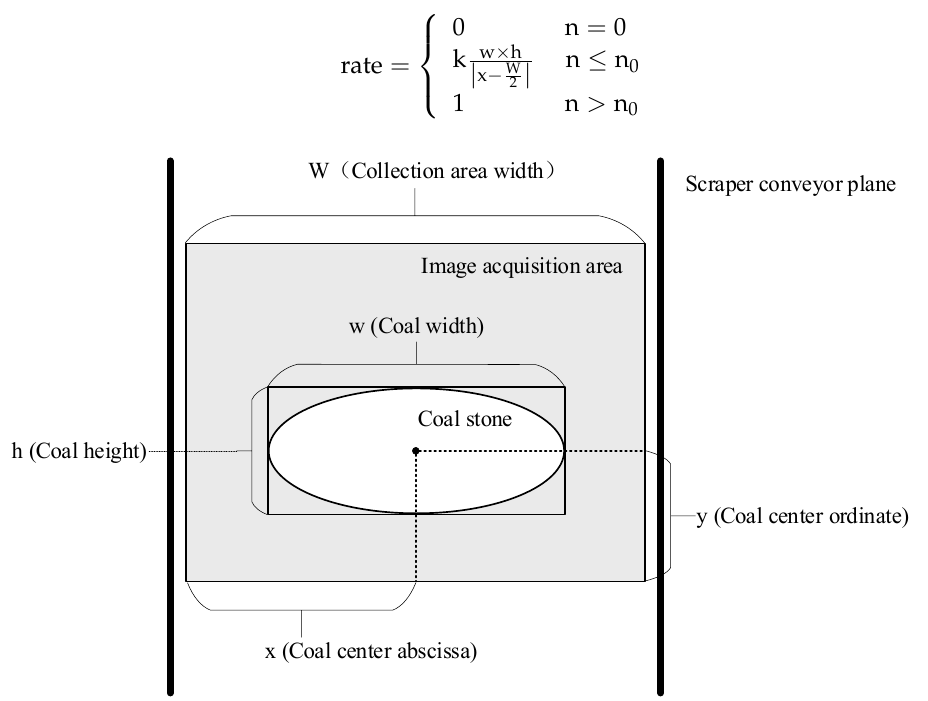
Figure 5. The position of coal on the scraper conveyor.